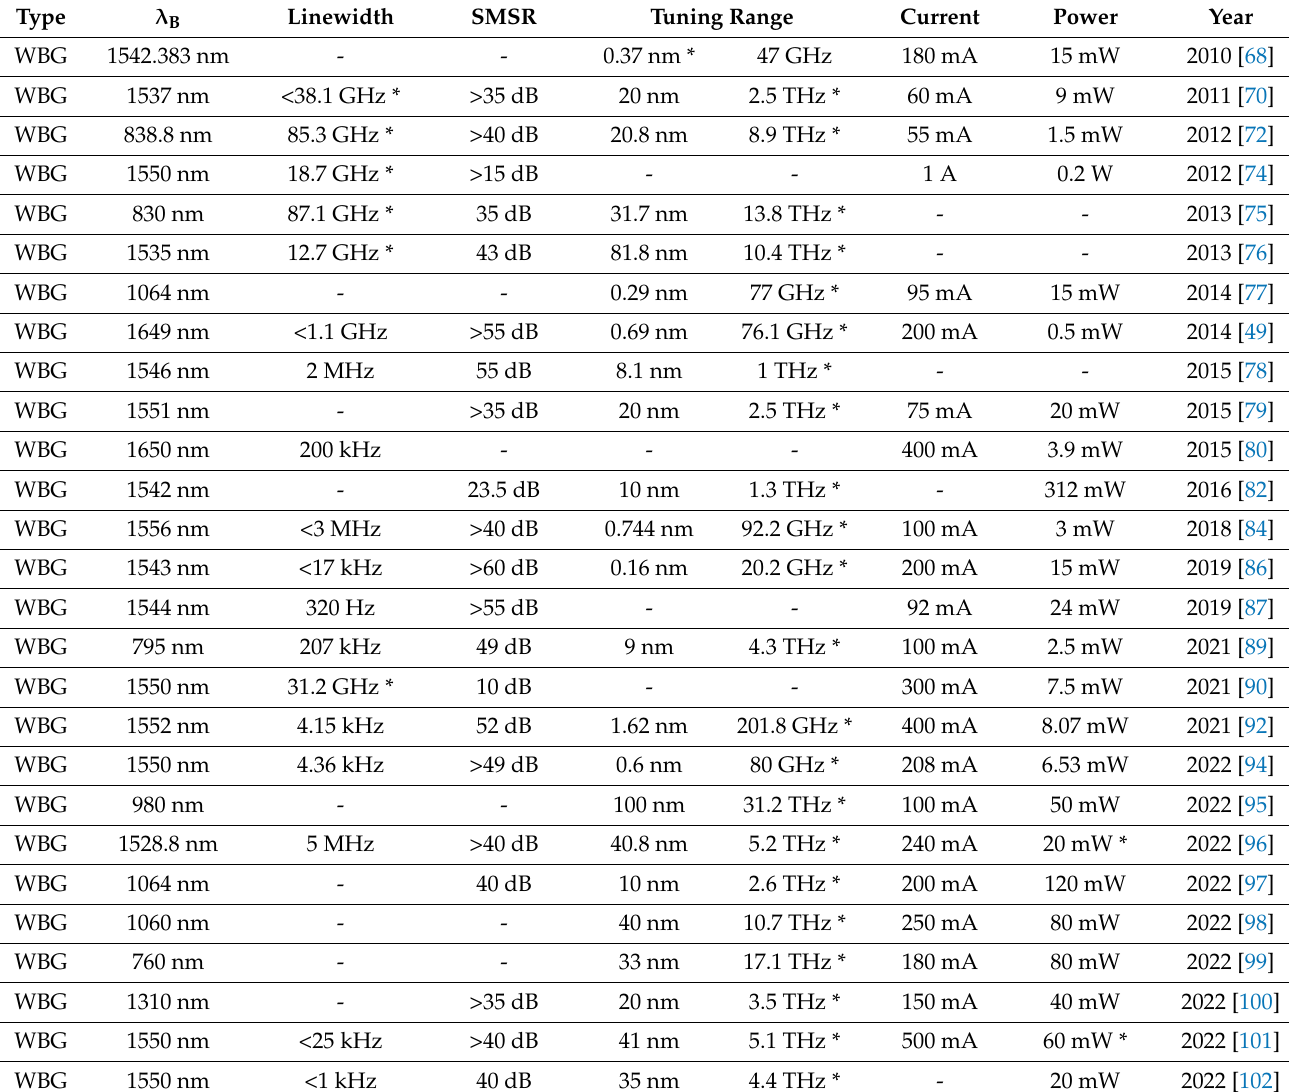
Table 3. The performances parameters of